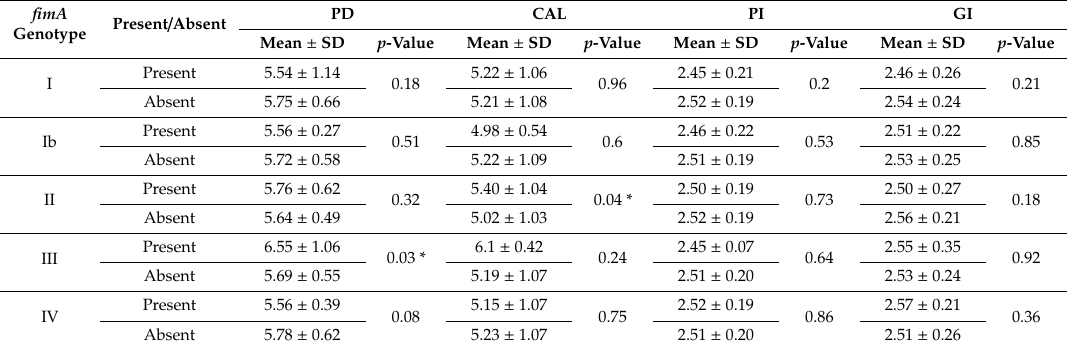
Table 3. Association of fimA genotypes with clinical parameters in patients with chronic periodontitis. fimA Genotype